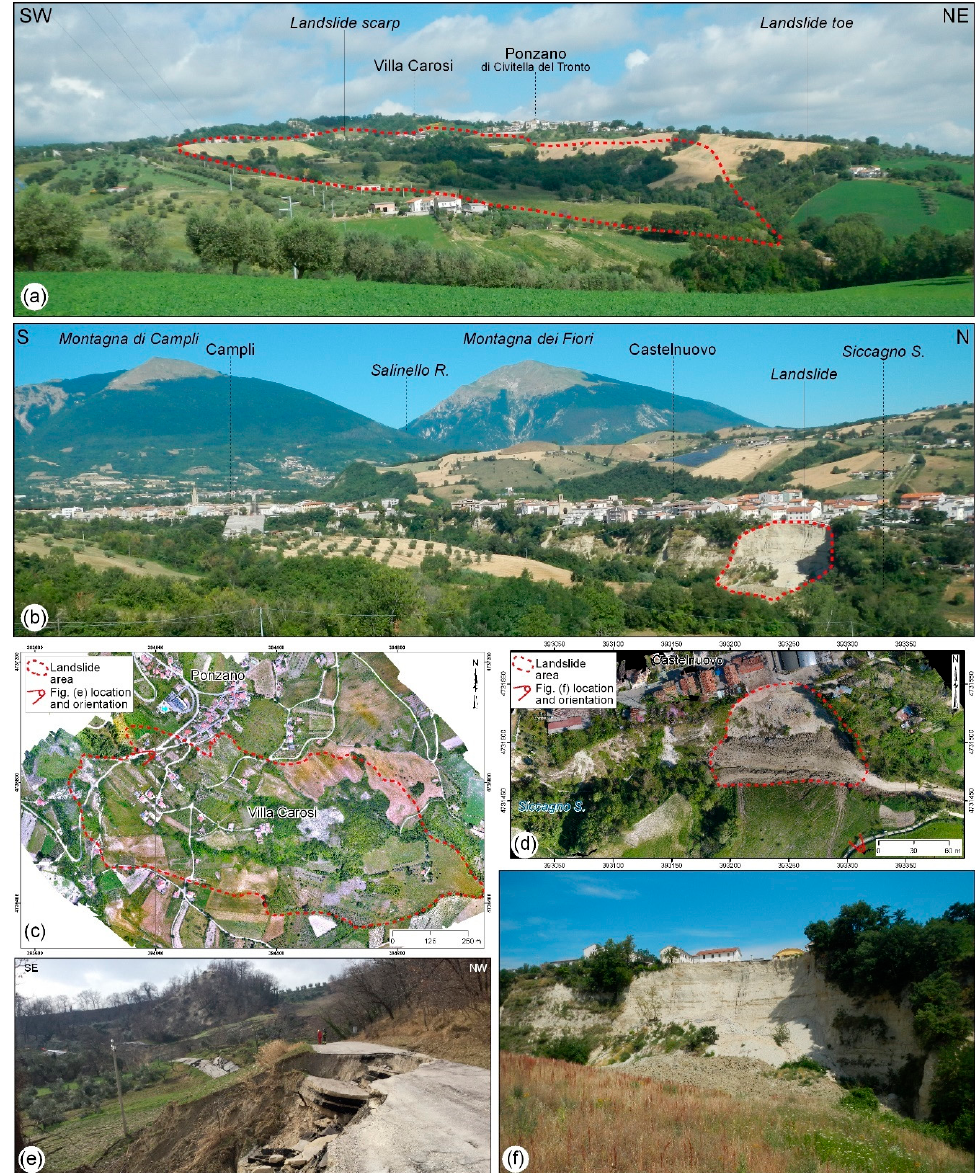
Figure 6. ( a ) Panoramic view of the Ponzano di Civitella del Tronto area (the red dashed line marks the landslide). ( b ) Panoramic view of the Castelnuovo di Campli area (the red dashed line marks the landslide). ( c ) Orthophoto of the Ponzano landslide derived by unmanned aerial vehicle (UAV) survey. ( d ) Orthophoto of the Castelnuovo landslide derived by UAV survey. ( e ) Panoramic view of the Ponzano landslide scarp. ( f ) Panoramic view of the Castelnuovo landslide. The Castelnuovo area is located in the Eastern part of the flat surface hosting the Campli village and is surrounded by steep scarps along the Fiumicino and Siccagno streams. The flat surface ranges in elevation from 350 to 400 m a.s.l., the valleys have elevations of 330 to <300 m a.s.l. (Figure 5) and the scarps are 50–80 m in height and range from very steep (>40°) to almost vertical (>80°). The landslide area is in the Southern scarp of the flat relief close to a gentle turn of the Siccagno stream. The scarp is very steep with vertical step and drops from ~375 m a.s.l. down to ~315 m a.s.l. The area is characterized by an E-W elongated mesa tabular relief on Middle Pleistocene alluvial fan deposits,